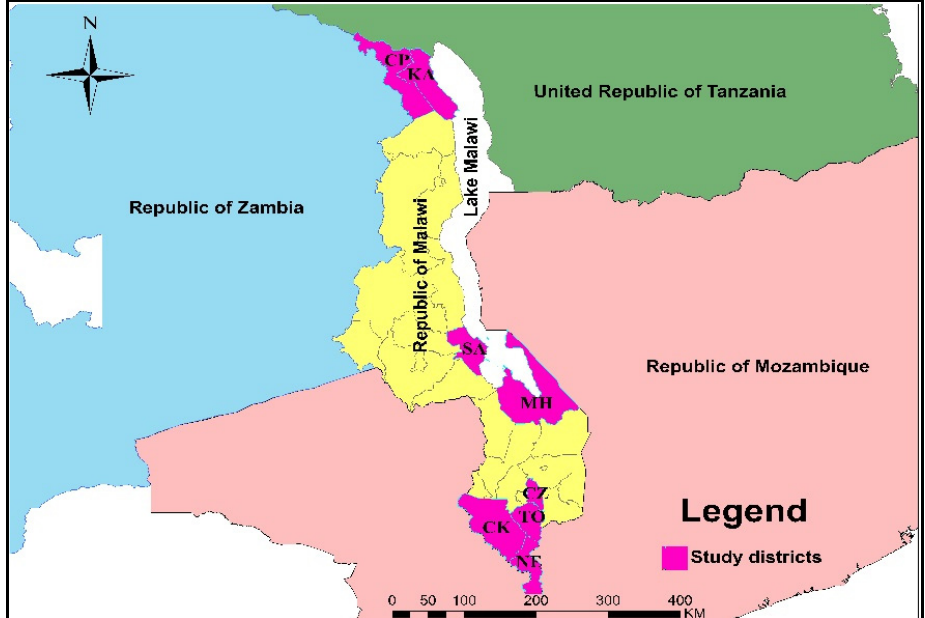
Figure 1. Map of Malawi showing the study districts. CP = Chitipa, KA = Karonga, SA = Salima, MH = Mangochi, CZ = Chirazulu, TO = Thyolo, CK = Chikwawa, and NE = Nsanje.